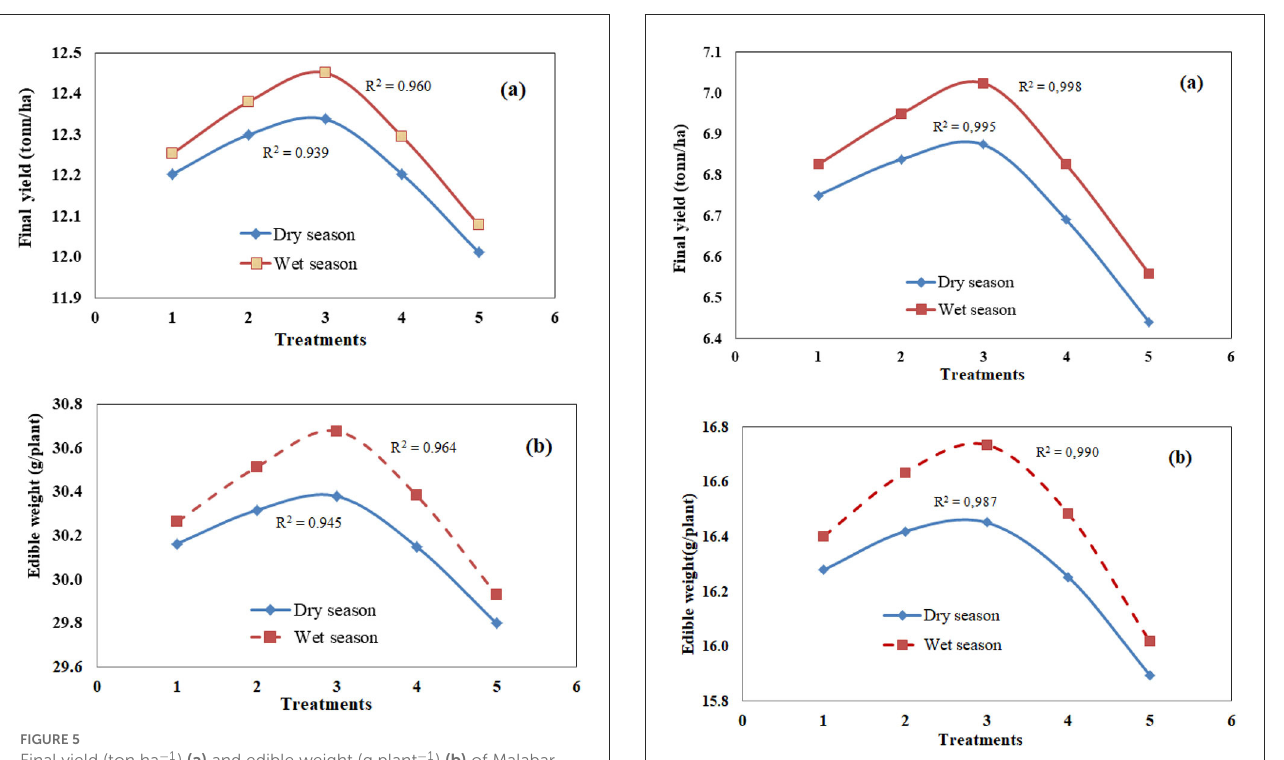
FIGURE6 Final yield (ton ha − 1 ) (a) and edible weight (g plant − ) (b) of Amaranthus cruentus ( Amaranthus L.) fertilized with five different treatments for the two